Question: Author a descriptive caption for the visualization shown.
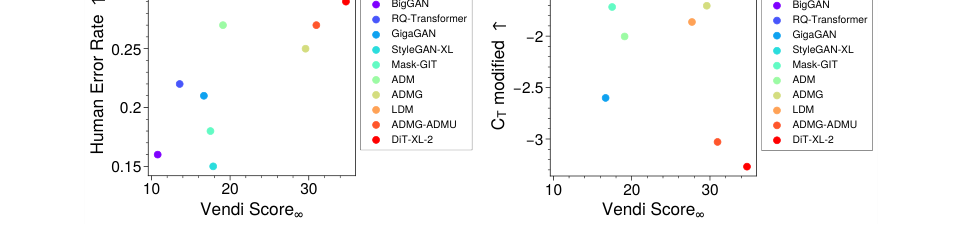
Answer: Vendi scores correlate strongly with human evaluation and memo- rization scores on CIFAR-10 and Imagenet256. Left: Human classification error rate vs. Vendi Score∞for models trained on CIFAR-10 (Top) and Imagenet256 (Bottom). Right: CT-modified vs. Vendi Score∞for models trained on CIFAR-10 (Top) and Imagenet256 (Bottom).